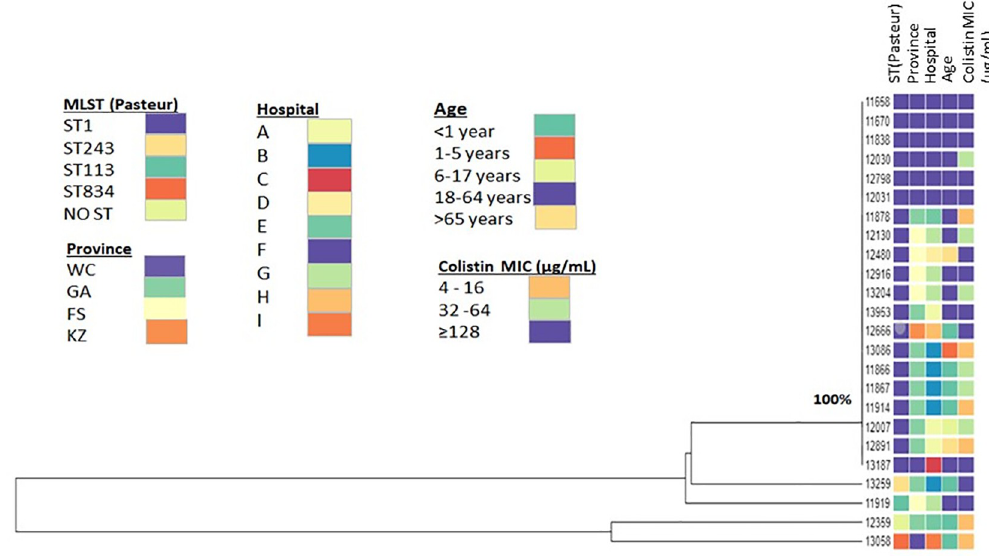
Fig 3. Phylogenetic comparison of colistin-resistant Acinetobacter baumannii bloodstream isolates from South Africa from 1 April 2017 to 30 September 2019, n = 24.